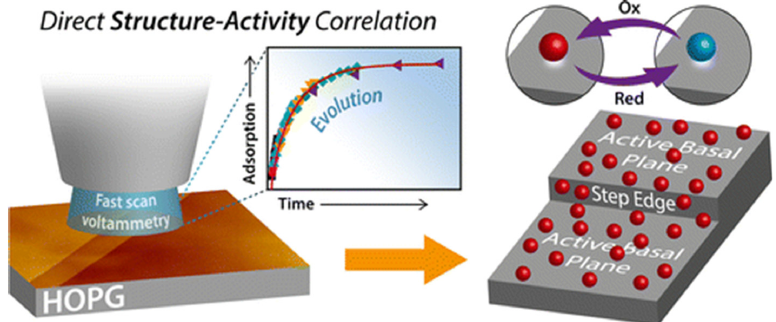
Figure 3. Schematic representation of the basal plane (active part) and the edge plane (less active part) of graphitic interface [24].